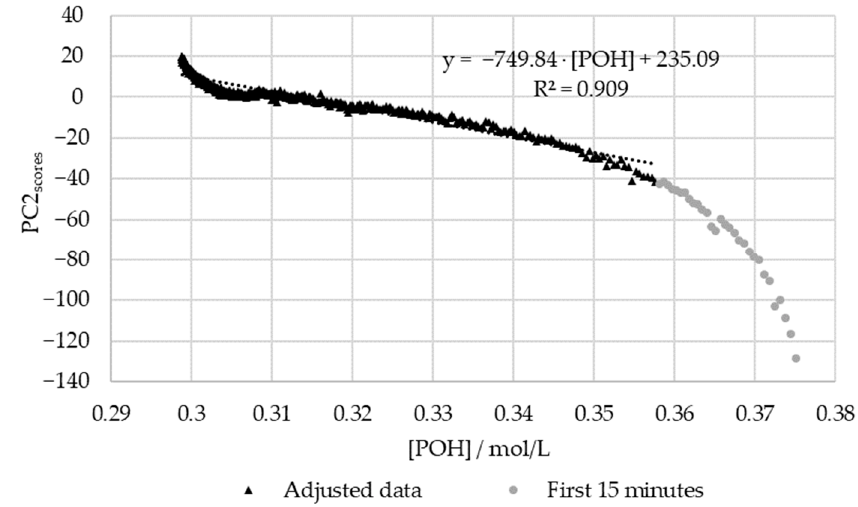
Figure 15. PC2 score vs. the decay of phenolic groups type I and II for the methylolation of the HLS sample at 60 °C.